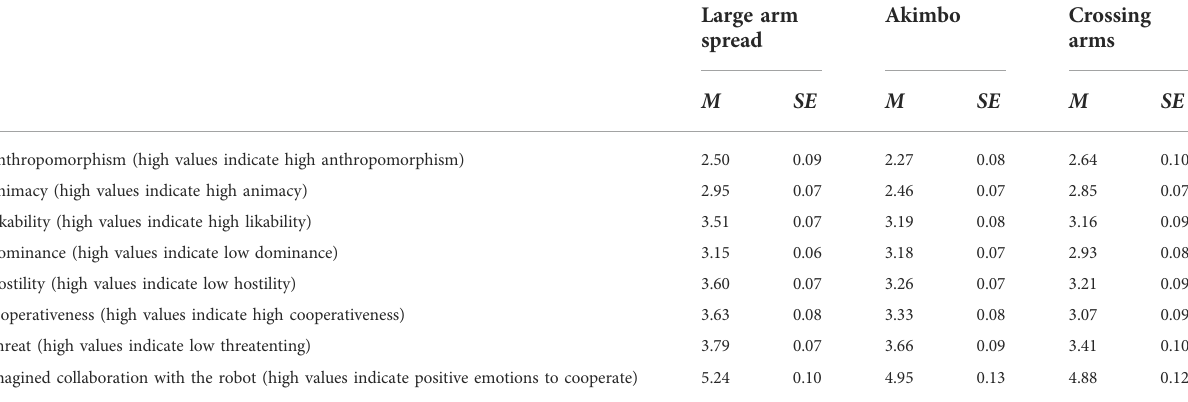
TABLE 4 Descriptive values of the three different gestures for all dependent variables.